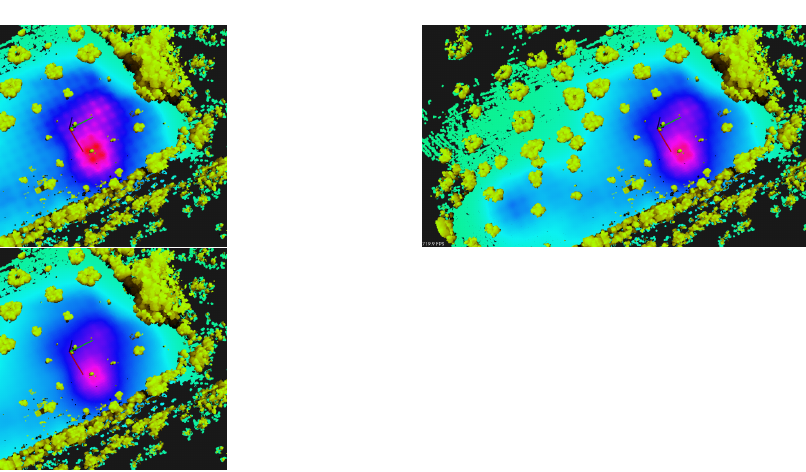
Figure 26. Heatmaps: GMC estimation in Counts per Minute from local C when at 1 m, 1.5 m, and 2 m above the ground. Maximum estimated value is 240 CPM, 195 CPM and 171 CPM